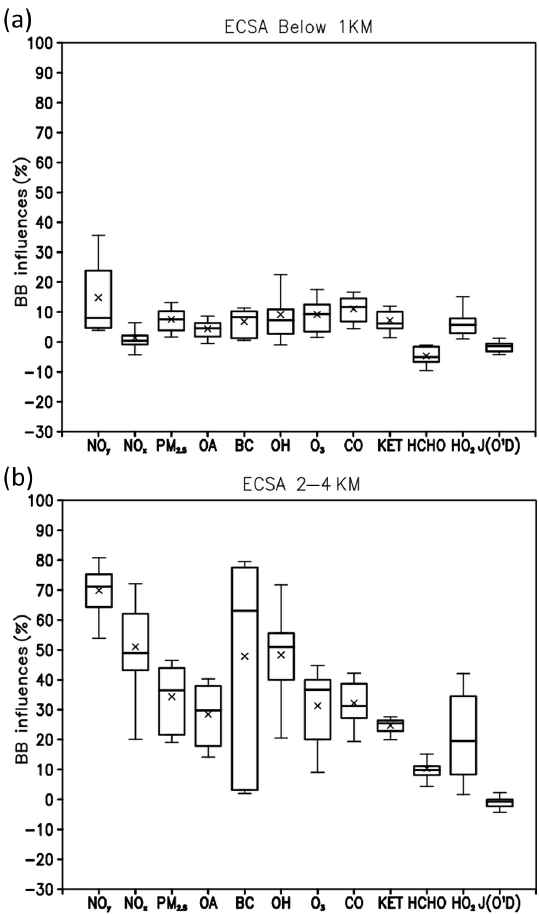
Figure 12. Boxplots of simulated BB influences (%) on NO y , NO x , PM 2 . 5 , OA, BC, OH, O 3 , CO, KET, HCHO, HO 2 , and J (O 1 D) over the region ECSA in Fig. 1a on 17 and 19 March 2018. (a) Below 1km and (b) between 2 and 4km.